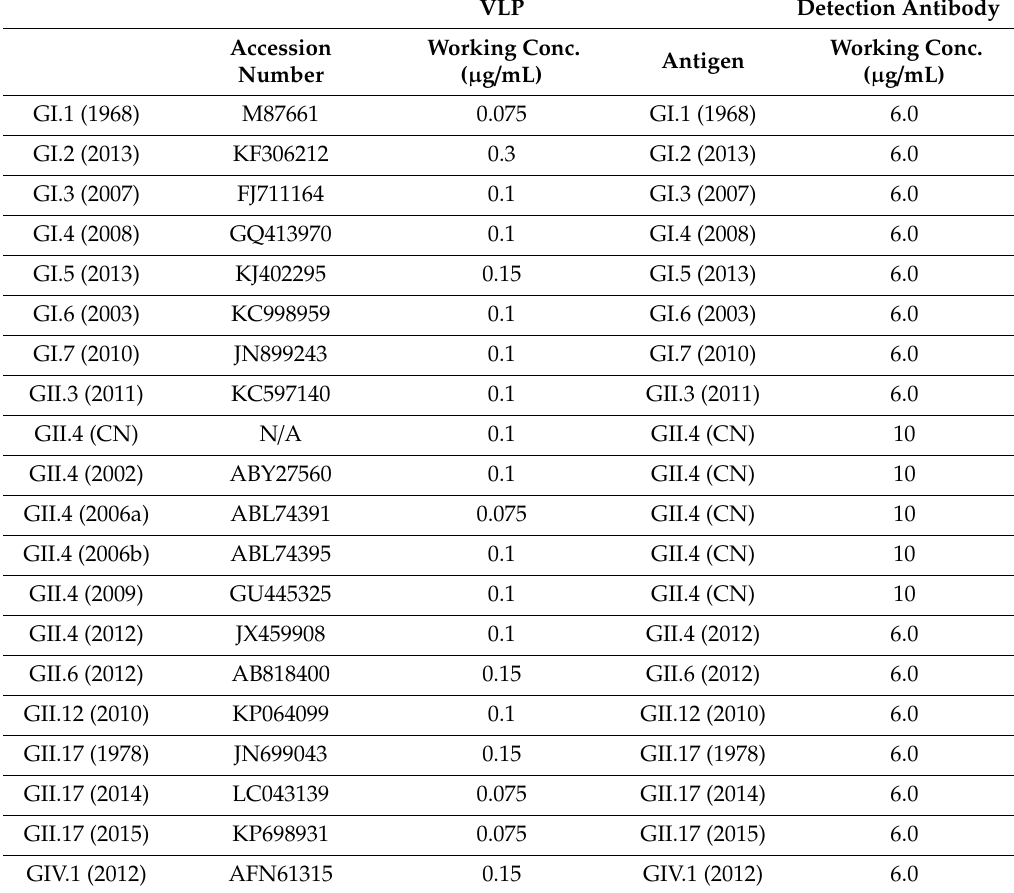
Table A1. Strain-specific